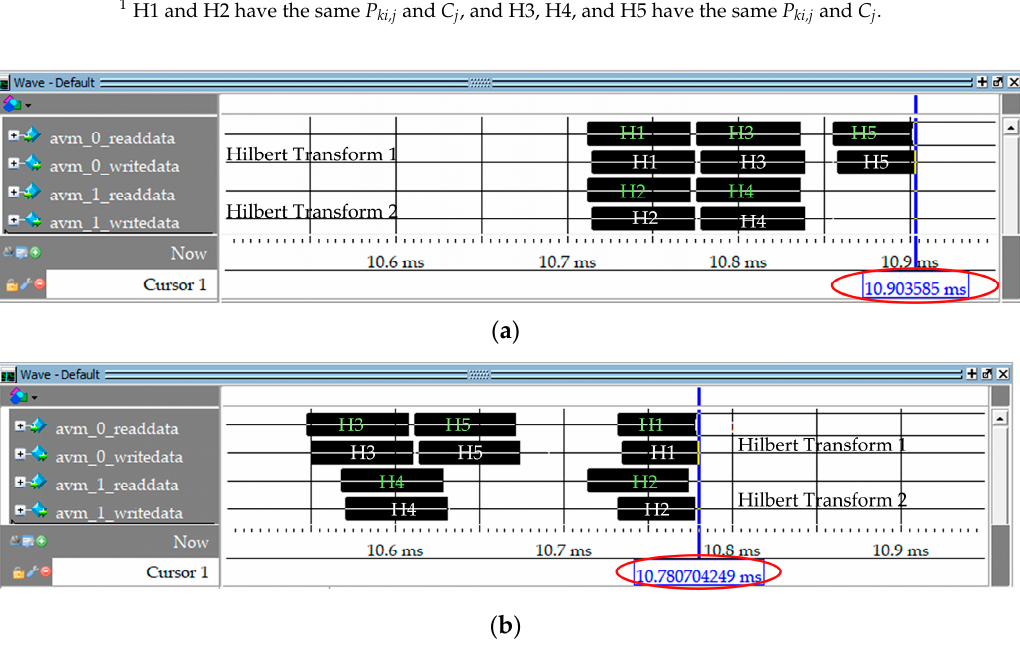
Table 16. Task Rank p of tasks in Hilbert transforms.